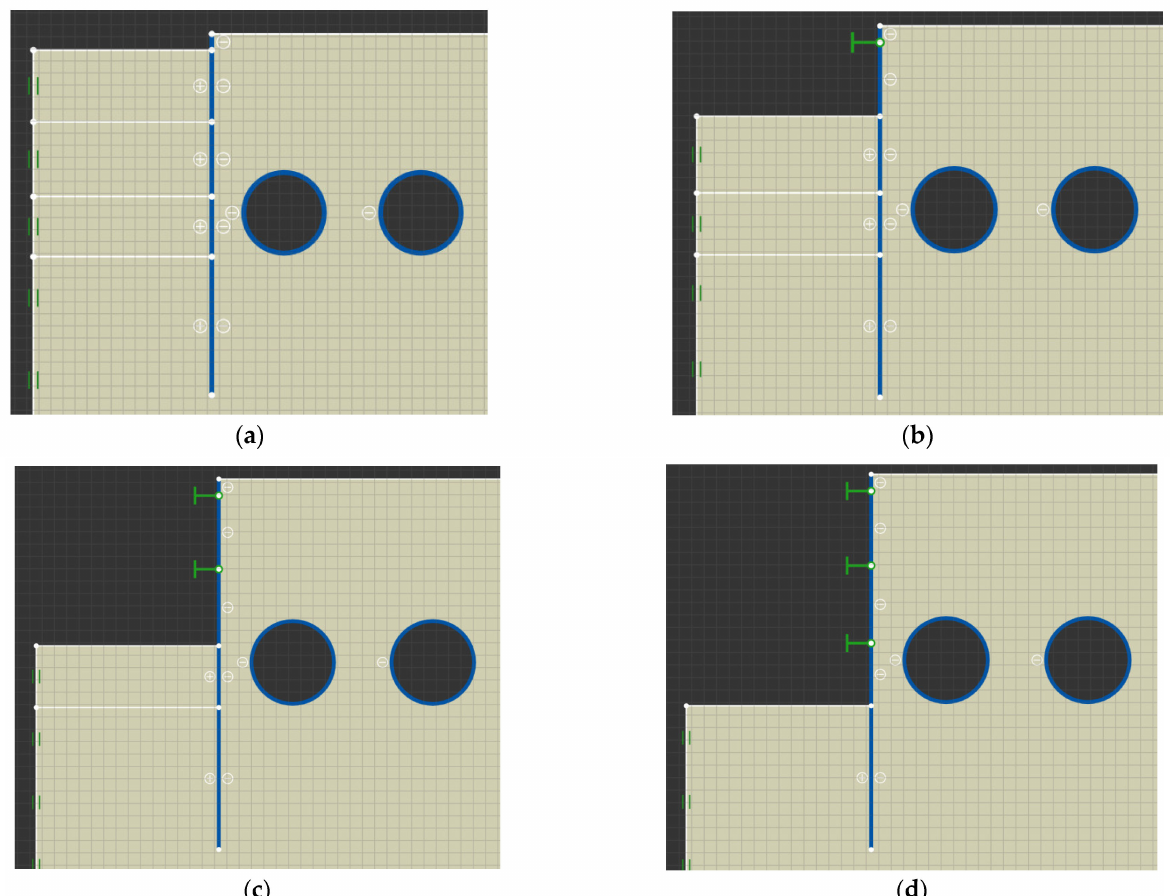
Figure 7. The construction scheme of the foundation pit: ( a ) Stage (1) ( h = 0.08 H), ( b ) Stage (2) ( h = 0.4 H), ( c ) Stage (3) ( h = 0.75 H) and ( d ) Stage (4) ( h = 1.0